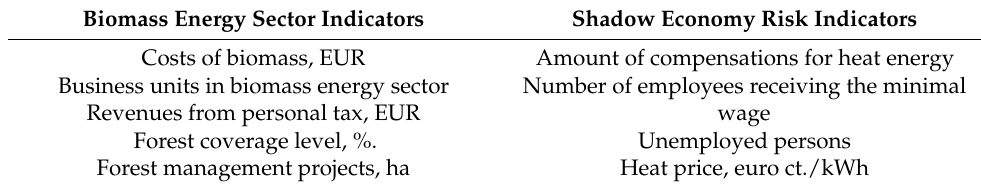
Table 3. Biomass energy sector and shadow economy risk